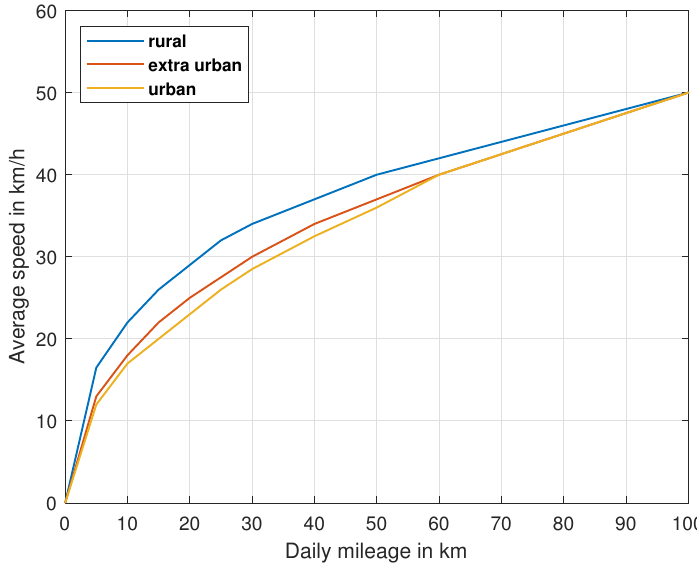
Figure 3. Average speed depending on the place of